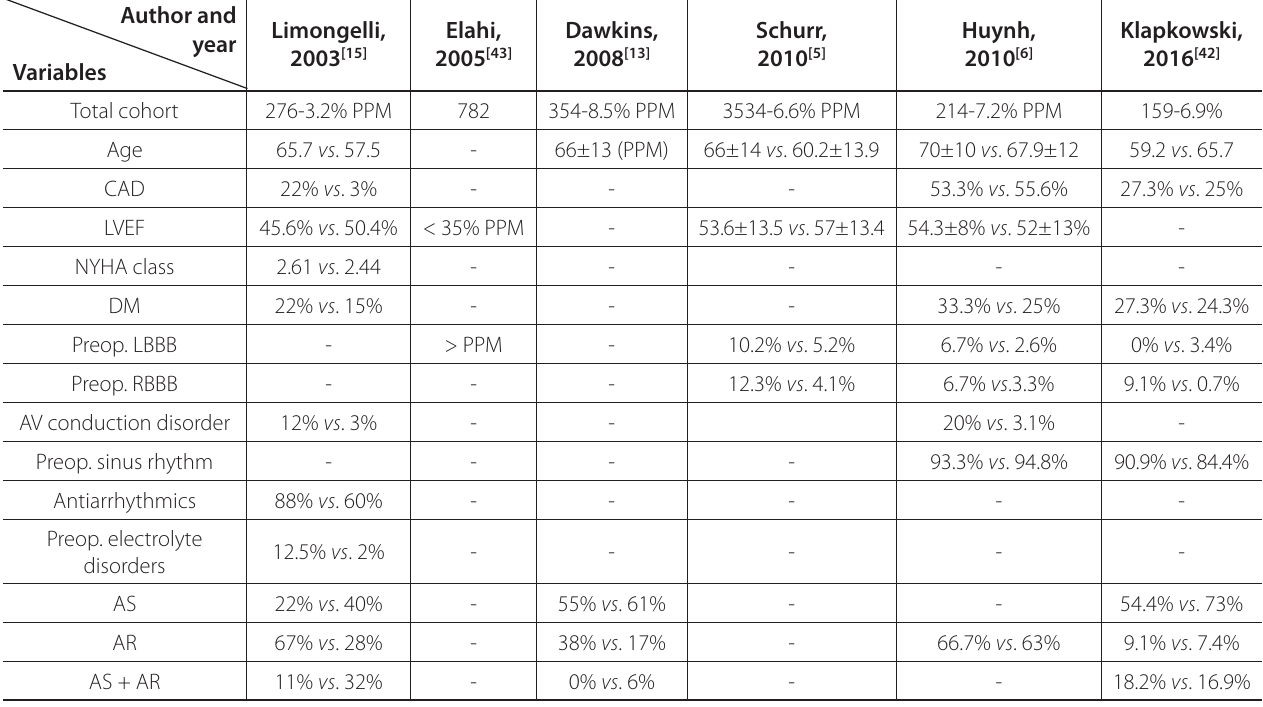
Table 3 . List of preoperative variables; PPM vs . non-PPM.